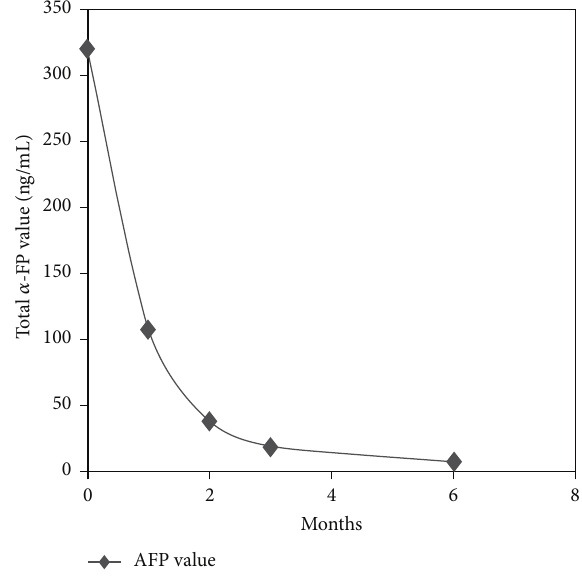
Figure 2: Changes in 𝛼 -FP levels after HSRT.